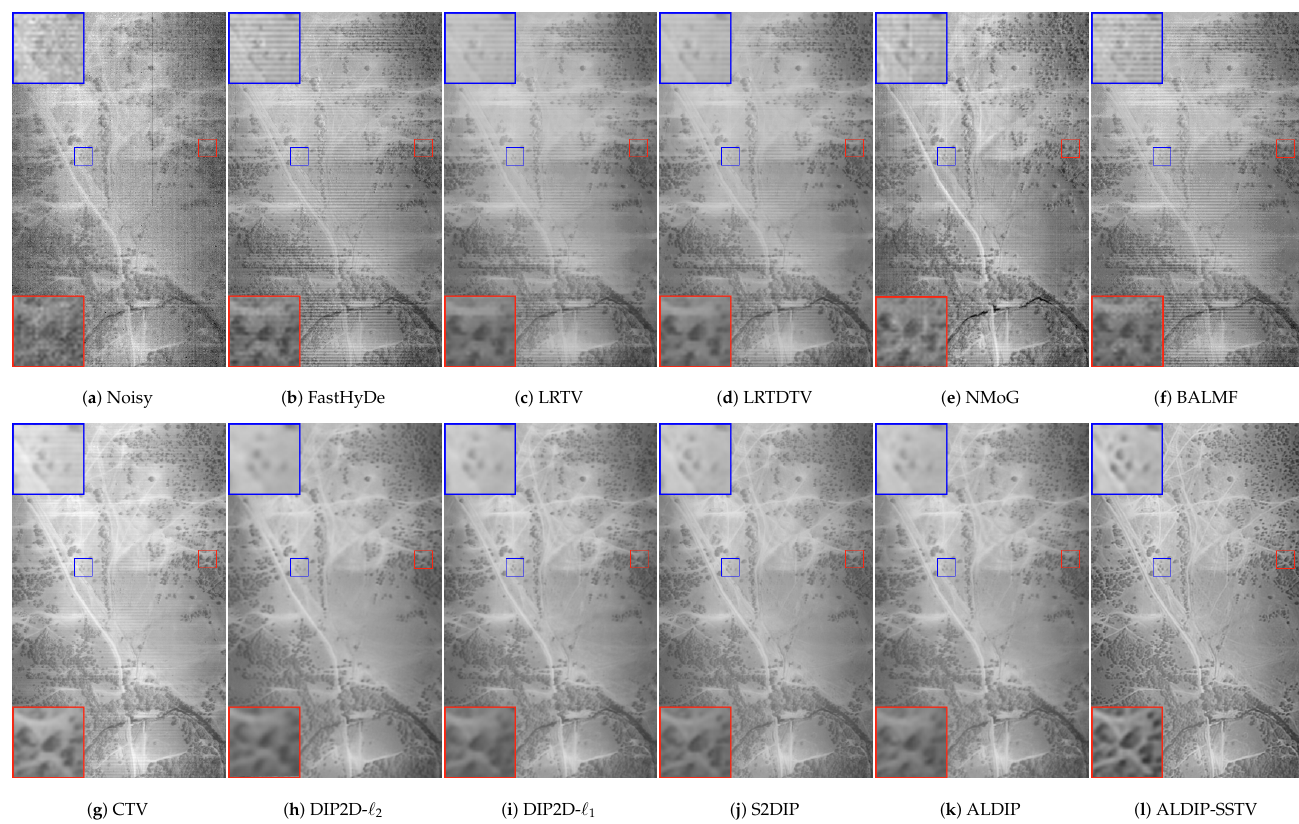
Figure 8. Noisy and denoising results by methods for comparison on real-world noisy HSI Shanghai dataset. The enhanced pseudo images consisted of the 152nd, 88th and 43rd bands are displayed. Two local areas (red and blue squares) are demarcated zoomed for easy observation.